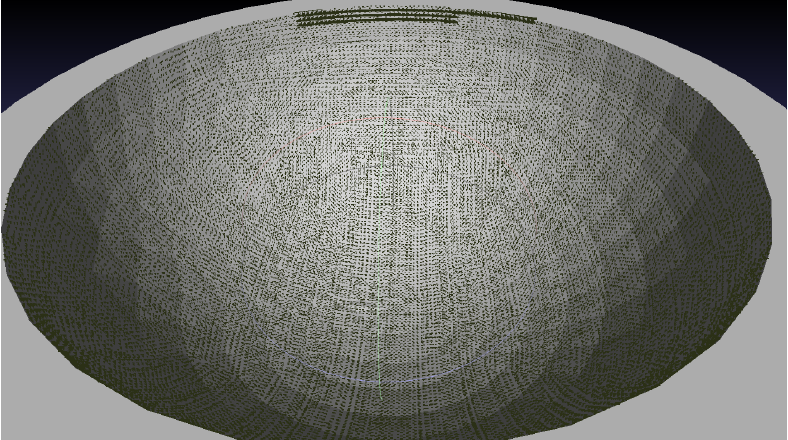
Figure 10. Points in bold display the extent of discovery with no over-sampling regime. Sampling rate: 1 mm, radius of bowl: 150